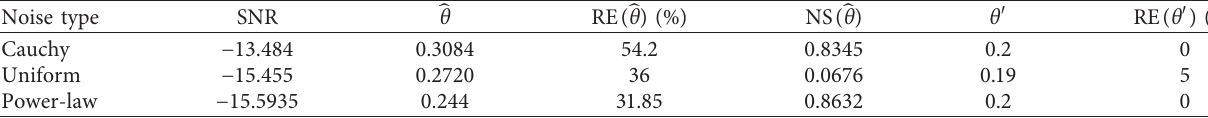
Table 5: Calibration performance for complex model.